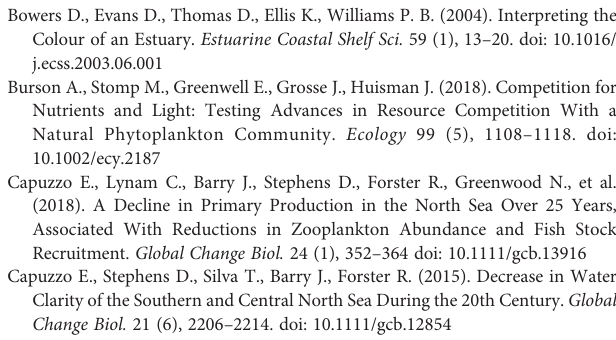
Supplementary Figure 2 | Temperature monthly climatologies for r2000 ( fi rst and third columns) and Global Reanalysis data (second and fourth column) for the years 2000 – 2004. Supplementary Figure 3 | Differences between daily climatology of <SST> of r1950 (blue), r2050_1 (yellow), r2050_2 (purple) and r2050_3, and r2000. Supplementary Figure 4 | Monthly climatologies for r2000 P 10 ( fi rst and third columns, in mmolNm -3 ) and CCI chlorophyll (second and fourth columns, in mgCHLm -3 ). Months November to February are ommited due to low P 10 in r2000 and data sparsity from cloud coverage in CCI data. Supplementary Figure 5 | Vertically averaged P 10 in mmolNm -3 (blue dots) for r2000 and ICES bottle data of chlorophyll in mgm -3 (red circles) against time for 2000 – 2004. For better visibility, the data are displayed for all areas individually, as well as for the whole domain (bottom left panel). Supplementary Figure 6 | Vertically averaged NO3 in mmolm -3 for r2000 (blue dots) and ICES bottle data (red circles) against time for 2000 – 2004. For better visibility, the data are displayed for all areas individually, as well as for the whole domain (bottom left panel). Supplementary Figure 7 | Vertically averaged PO4 in mmolm -3 for r2000 (blue dots) and ICES bottle data (red circles) against time for 2000 – 2004. For better visibility, the data are displayed for all areas individually, as well as for the entire domain (bottom left